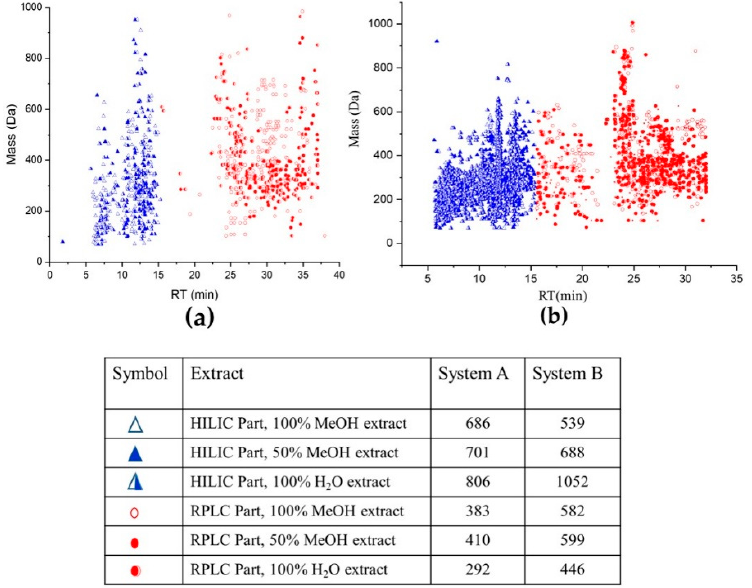
Figure 2. Retention time (RT)—the mass plot of Lemna minor metabolic profile extracted with 100% MeOH, 50% MeOH, and 100% H 2 O; using ( a ) system A (single TOF-MS) and ( b ) system B (QTOF- MS/MS). The blue color represents the HILIC eluting metabolites and the red color the RPLC eluting metabolites. The included table reflects the corresponding amount of